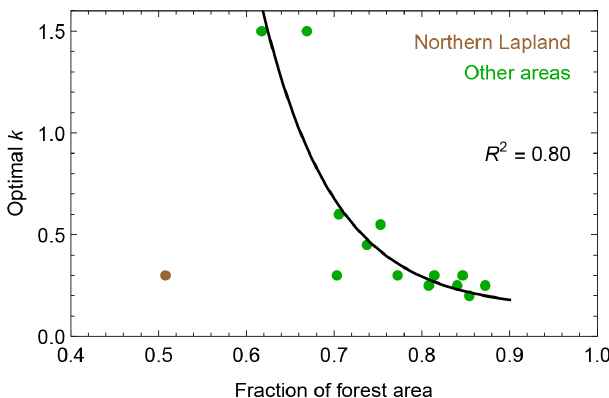
Figure 3. Optimal values of k as a function of the fraction of the forested area in the forest centre area ( f ) . The brown point is not included in the regression k = 0 . 11 + 1347 . 44 exp( − 11 f ), because it represents an area dominated by deciduous species (mountain